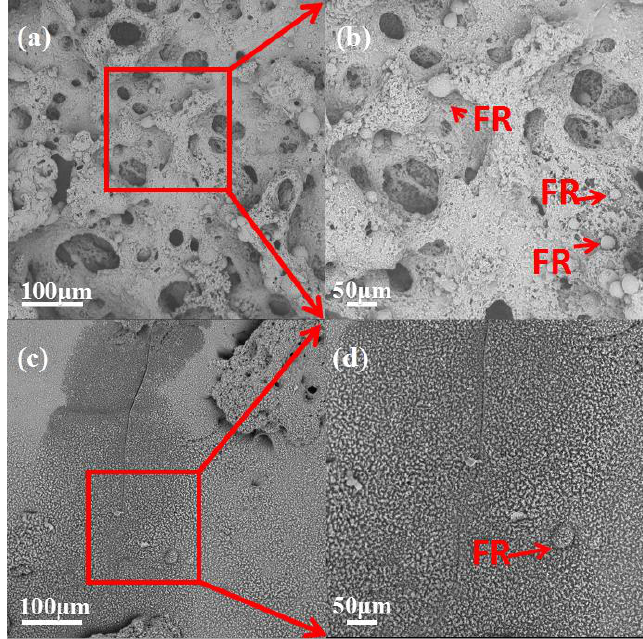
Figure 8. SEM images of PLA/HABP-DOPO blends after cone calorimeter tests. ( a ), ( b ) PLA/15 wt% HABP-DOPO and ( c ), ( d ) PLA/25 wt% HABP-DOPO.